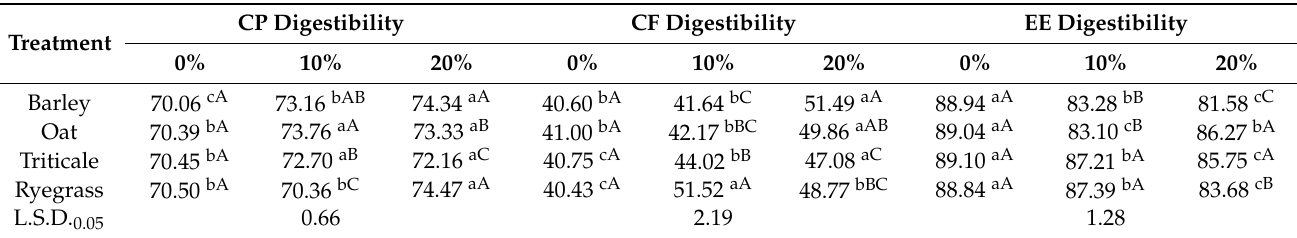
Table 6. Means of the digestibility (%) of crude protein contents (CP), crude fat (CF), and ether extract (EE) as affected by the interaction between the crop and its percentage in the